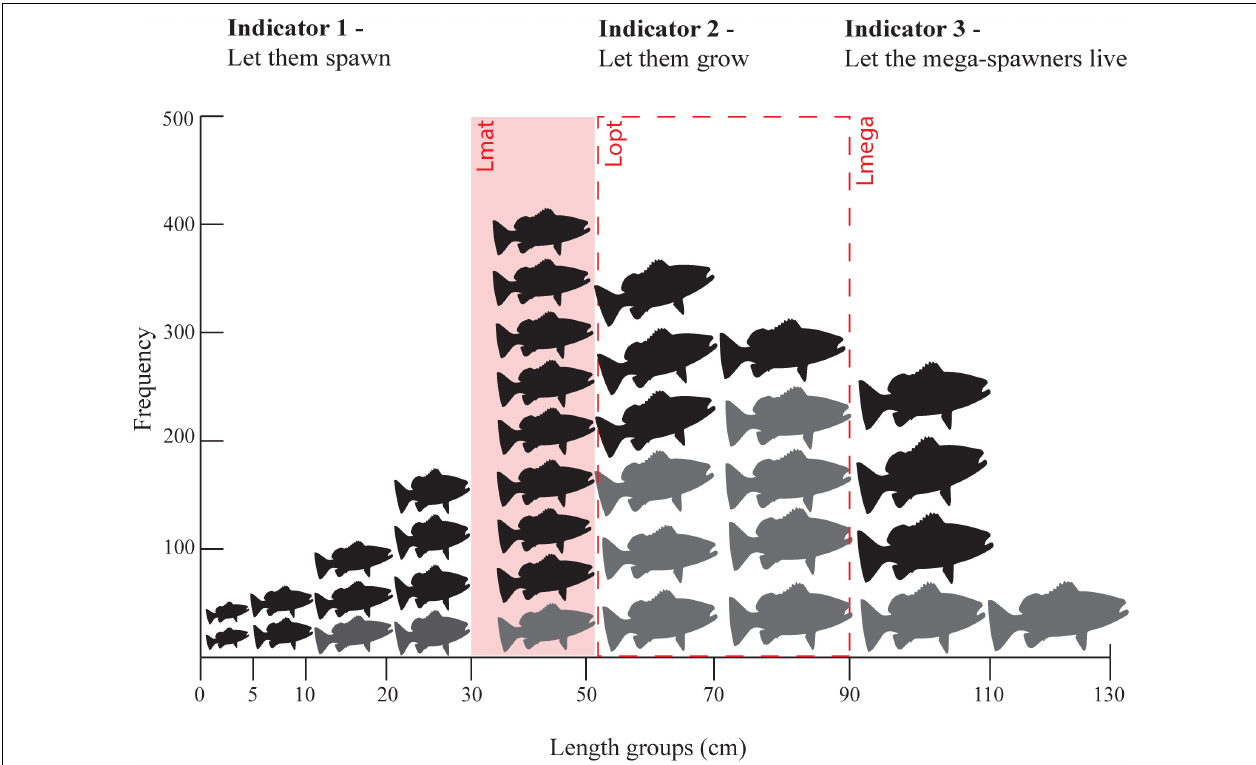
FIGURE 2 | An example of a length frequency distribution (all fish) with Froese’s indicators of overfishing in red. Indicator 1 – P mat proportion of fish below the length at maturity (L mat ) (fish to the left of the red rectangle are considered juvenile fish), Indicator 2 – P opt proportion of optimally sized fish, those between 0.9 and 1.10 of optimal length (L opt ) indicated by the red dotted rectangle, and Indicator 3 – P mega proportion of fish more than 1.10 times L opt (fish to the right of the red dotted rectange). Fish colored in grey represent the length frequency distribution that should be found in the catch in ideal conditions according to Froese’s targets (Suggested targets are 10% below L mat , 100% at L opt , and upto 30% L mega